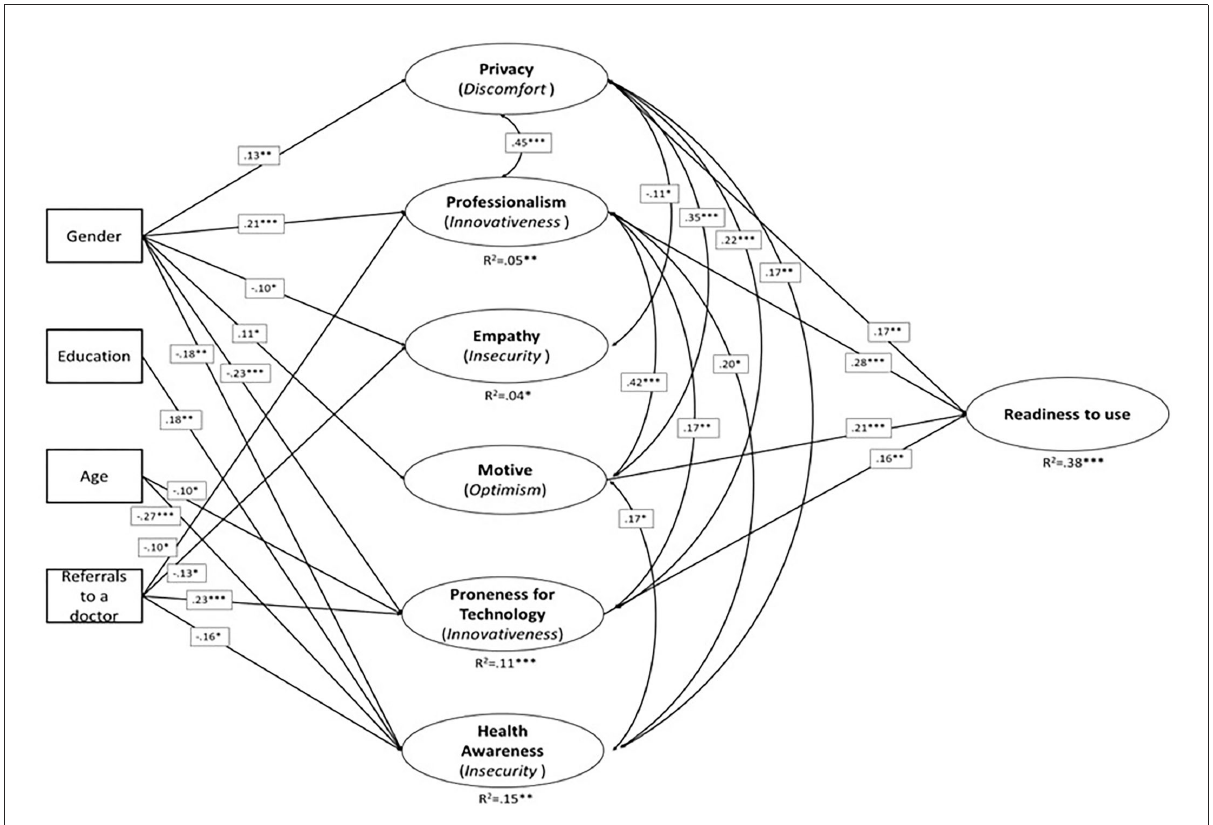
FIGURE3 Full illustration of the structural model results.